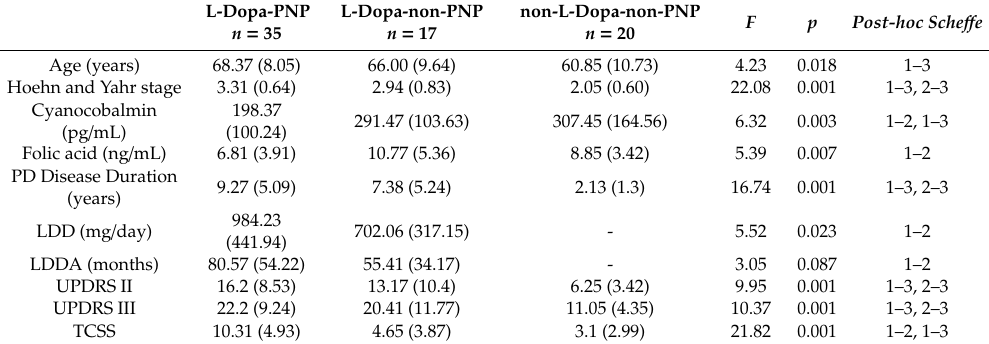
Table 3. Results for the Analysis of Variances (ANOVA) and Sche ff e post-hoc analyses (pairs of groups with significant di ff erences). Results are represented as mean (SD). PD, Parkinson’s disease; LDD, L-Dopa daily dose; LDDA, L-Dopa duration of administration; TCSS, Toronto Clinical Scoring System; PNP, Large-fiber